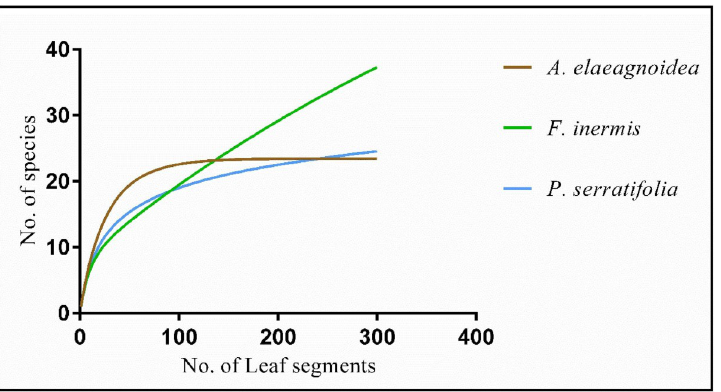
Fig 12. Species accumulation curves of foliar endophytic fungi recovered from Magnoliopsida plants.